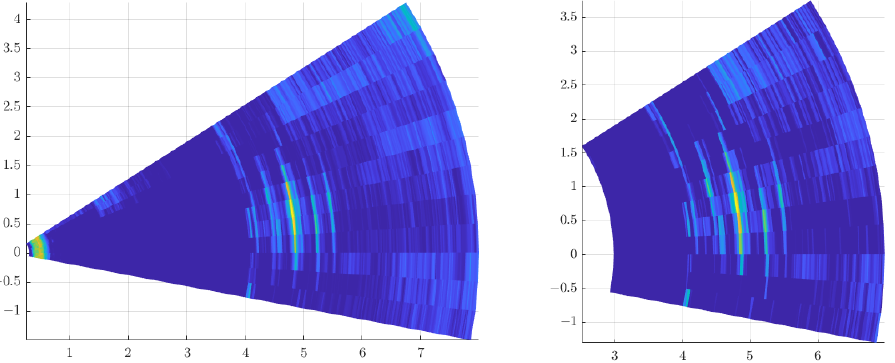
Figure 5. An example of determining ROI. This pre-processing technique reduces image area for faster image processing. [own